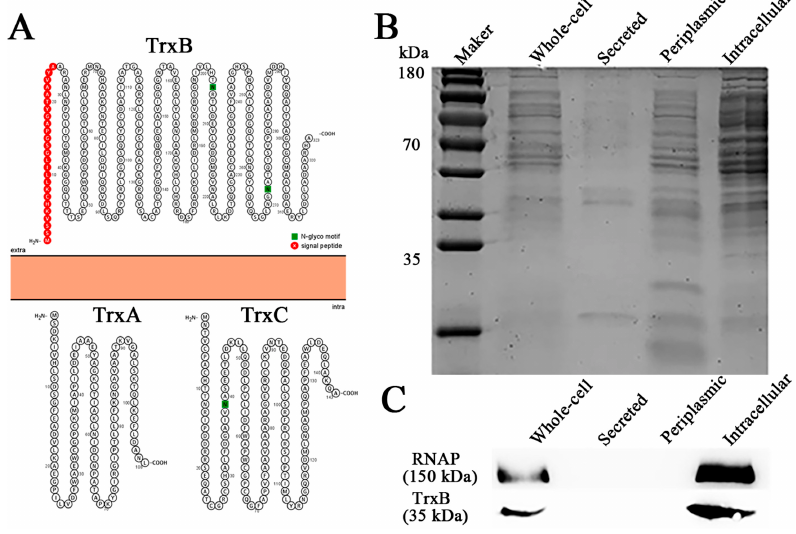
Figure 2. Cellular localization of TrxB Ep . ( A ) Protter illustration of TrxB Ep , TrxA Ep and TrxC Ep . ( B ) protein components of Edwardsiella piscicida cells. ( C ) The distribution of TrxB Ep tested by Western blot. 3.3. Construction of Mutant Strains of Trx System In order to further study the function of the thioredoxin system, we constructed three mutants— Δ trxA , Δ trxB , and Δ trxC —by deleting the gene segment from 64 to 234 of trxA Ep , 115 to 858 of trxB Ep , and 103 to 319 bp of trxC Ep (Figure S4). 3.4. The Trx System Is Involved in the Resistance against Oxidative Stress, Acid Stress, and Iron Deficiency Stress